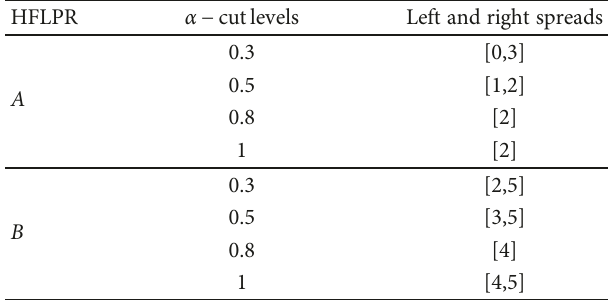
Table 1: The right dominance of A and B .